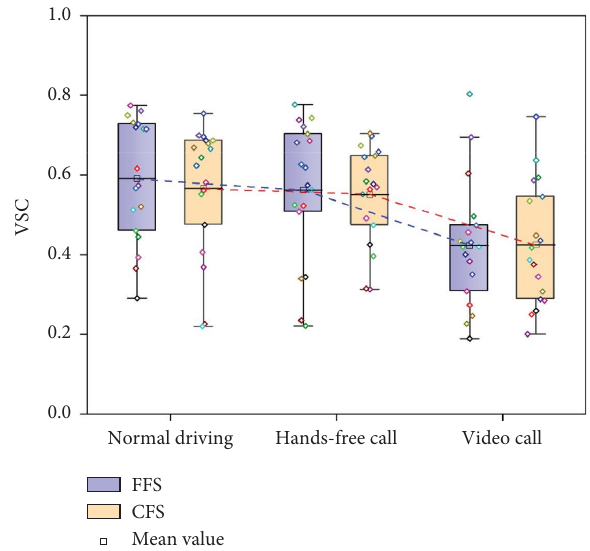
Figure 11: Comparison of drivers’ VSC for each driving state in diferent trafc conditions.